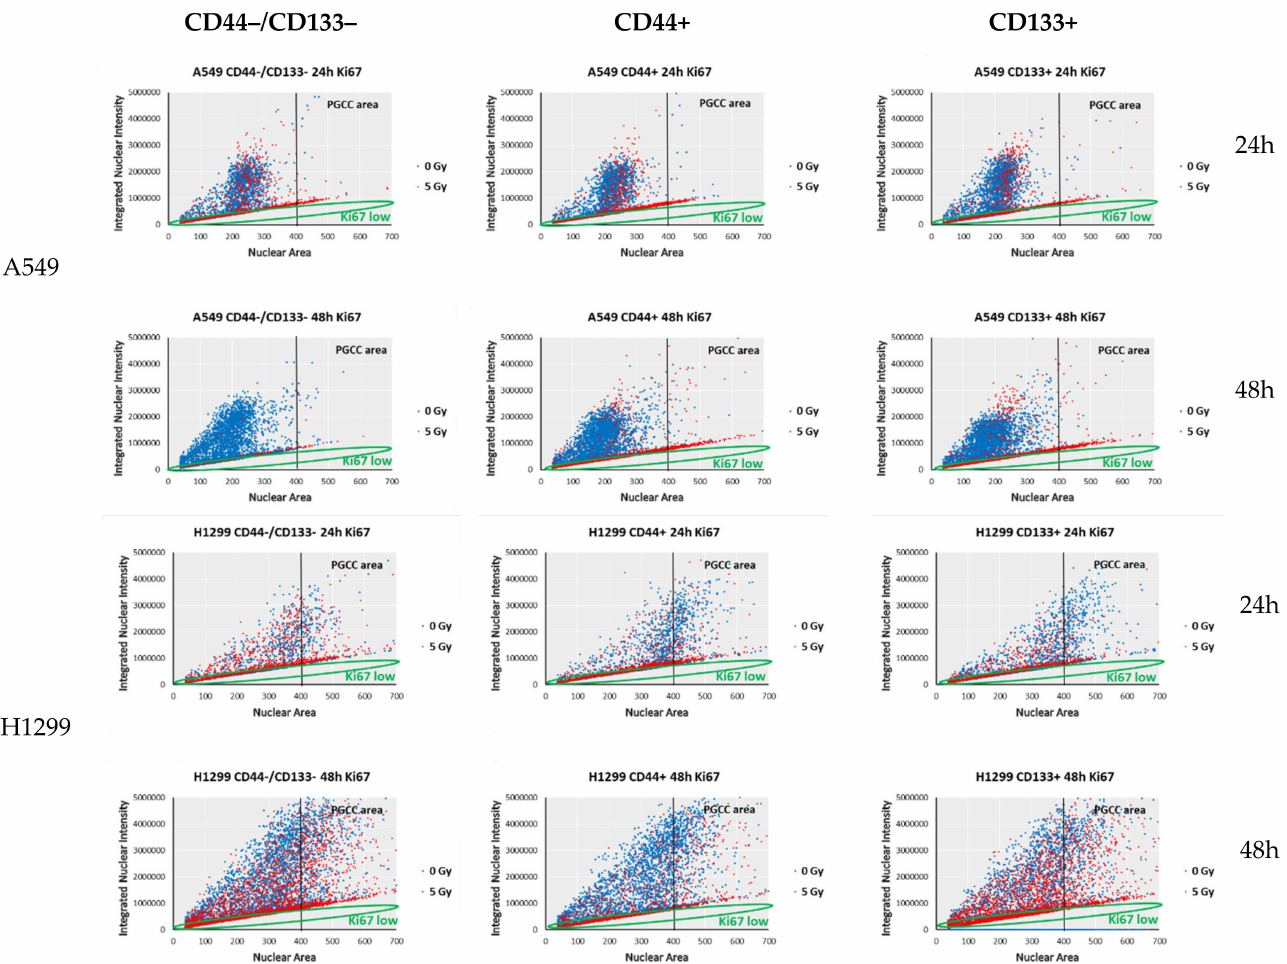
Figure 7. Ki67-coupled fluorescence-intensity analysis of distinct cell-cycle characteristics 24–48 h after 0 Gy (blue dots) or 5 Gy (red dots) exposure. The ImageXpress Micro XL High-Content Analysis of Ki67 fluorescence intensities in sorted populations. Green circles demonstrate Ki67 low area of “quiescent” (G0/G1 arrested) cells. Data are means ± SD of three independent experiments. PGCC/MGCC fractions featuring SCP were progressively augmented only in the CD44+ and CD133+ A549 cells, demonstrating the stable Ki67 low phenotype at 24–48 h after irradiation (Figure 7, red dots, PGCC area), which was not evident in the CD44 − /CD133 − population of the same cell line. In contrast, PGCC/MGCC fractions of all the sorted